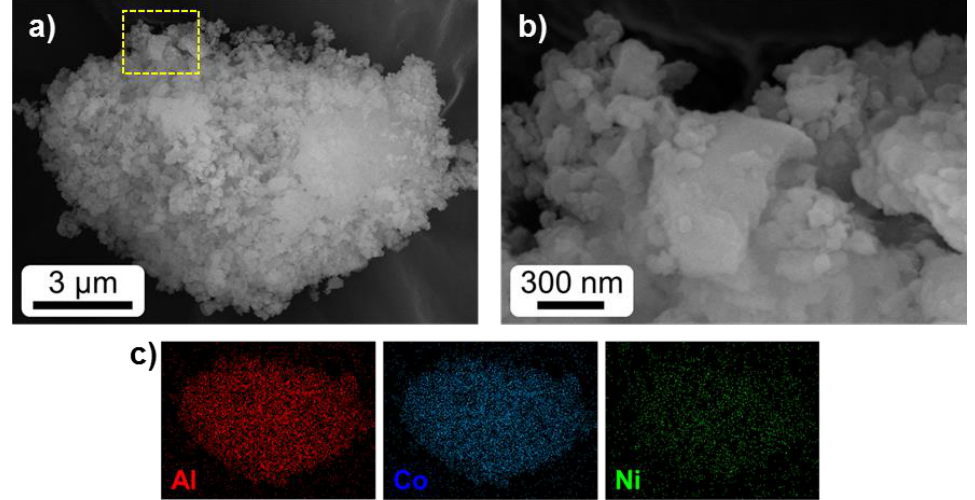
Figure 1. ( a ) FE-SEM micrograph of the Ni / CoAl 2 O 4 catalyst, ( b ) HR-SEM magnification of the area marked in yellow in ( a ), and ( c ) EDX elemental mapping obtained in ( a ).